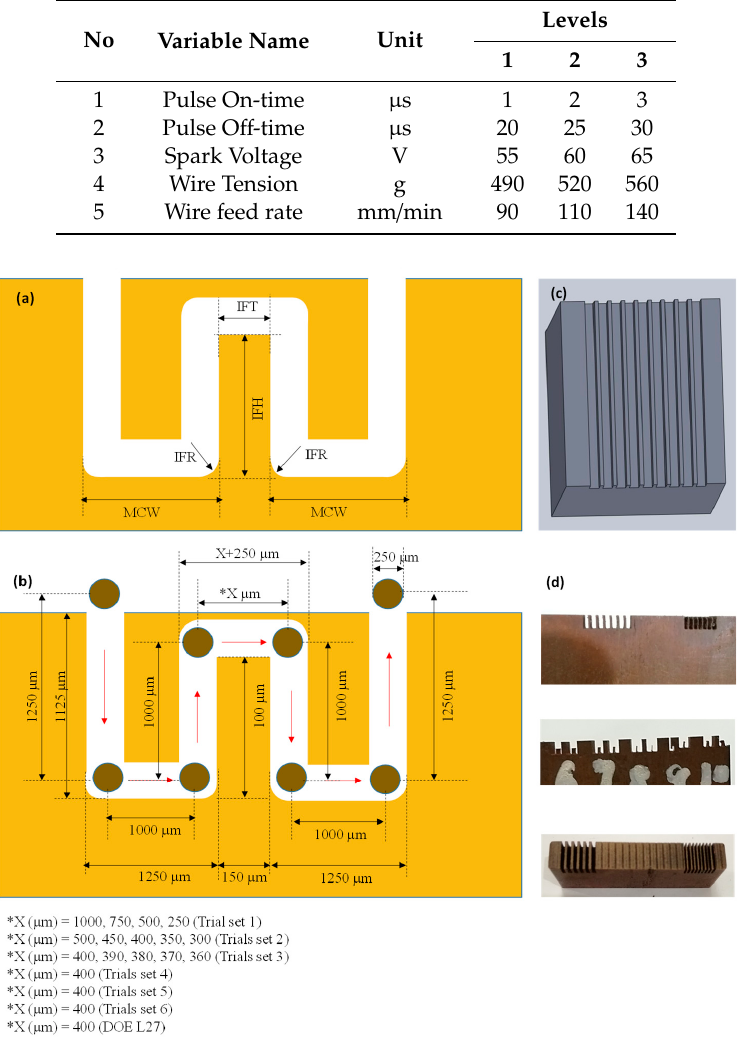
Figure 1. Micro-channels fabricated through wire electrical discharge machining (WEDM): ( a ) schematic of responses, ( b ) schematic of micro-channel features with dimensions, ( c ) 3D computer-aided design; CAD model of the designed micro-channels, and ( d ) actual machined samples.